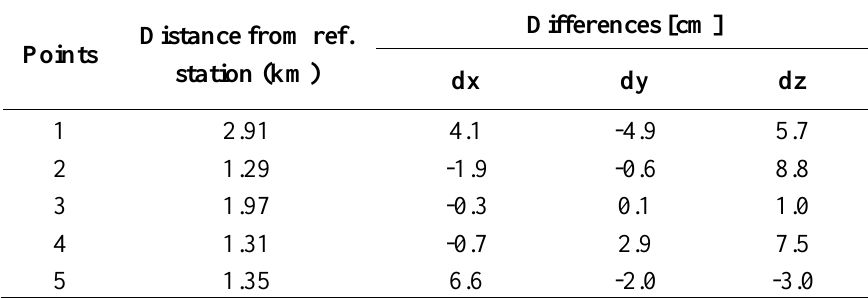
Table 4. Differences in coordinates between static and RTK GPS positions.